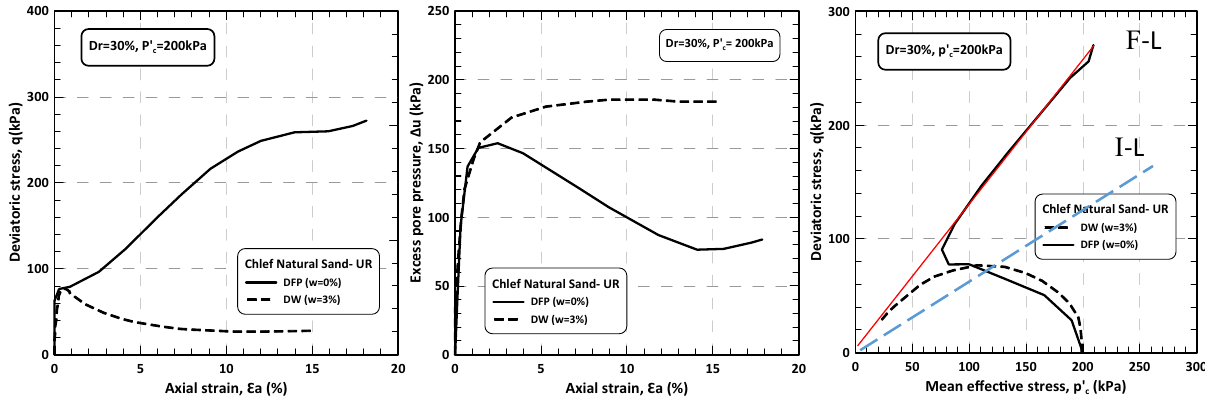
Fig. 7 Effect of deposition method on the undrained response of unreinforced sand samples at p ′ stress versus axial strain, b excess pore pressure against axial strain, c effective stress